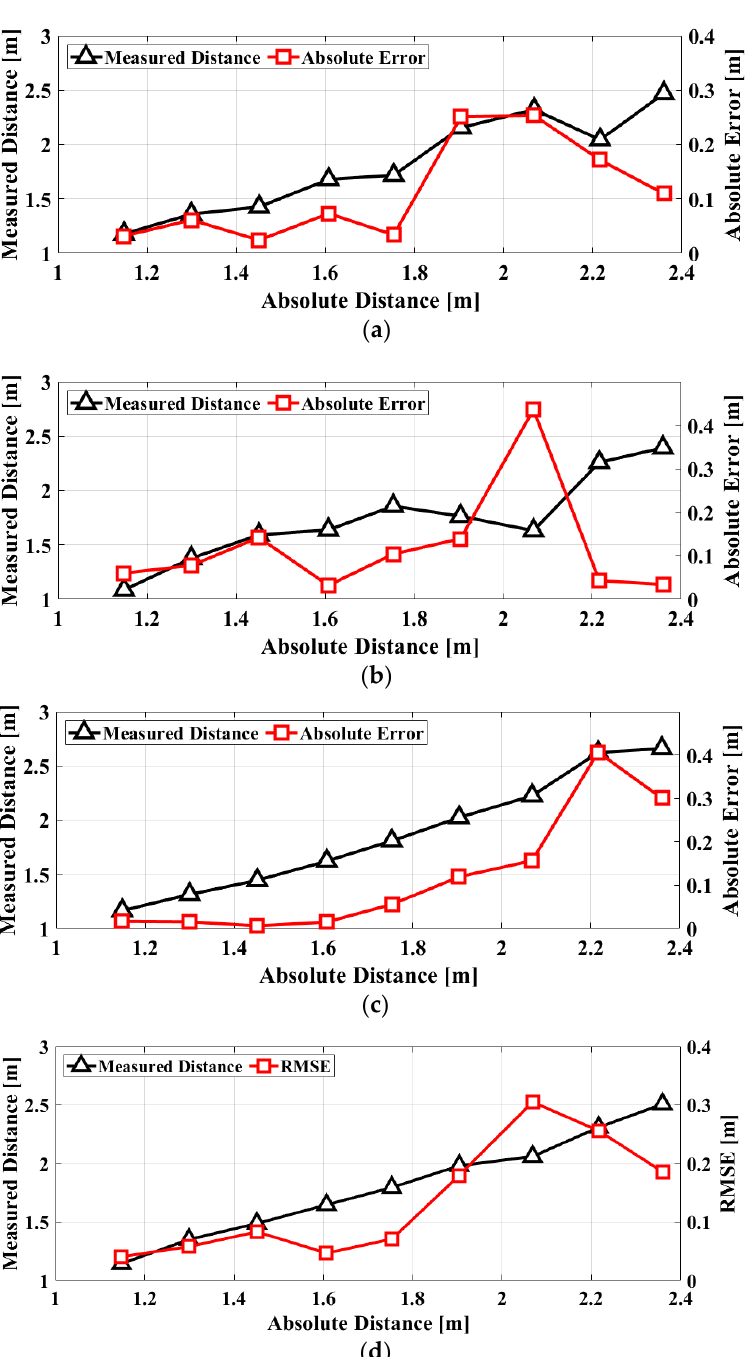
Figure 10 (based on a comparison between the single frequency and cross-correlated signals) indicates that the frequency resolution can be increased by the cross-correlation.